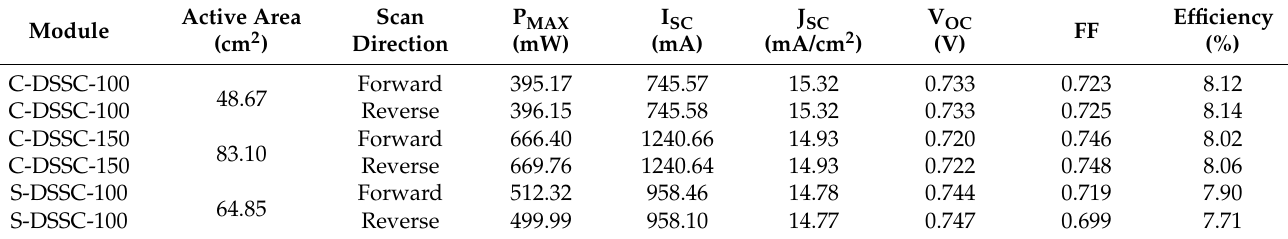
Figure 8. Stability photovoltaic performance of a 10 cm × 10 cm ( a ) C-DSSC and ( b ) S-DSSC module. (Insert: actual module photo picture.) ( c ) The efficiency trend of dye-sensitized solar modules at different temperatures of electrolyte injection. Table 2. PV parameters of various-sized grid-type DSSC modules (MPN based ELE.) under AM1.5 G illumination.